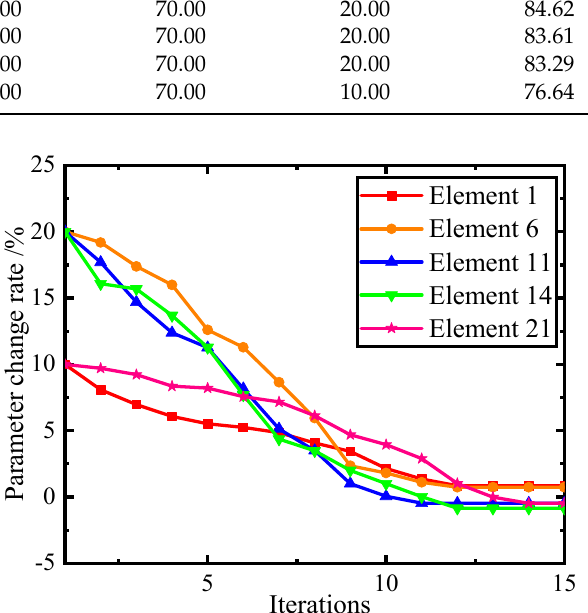
Figure 5. Convergence process of designed parameters under 5% white noise.